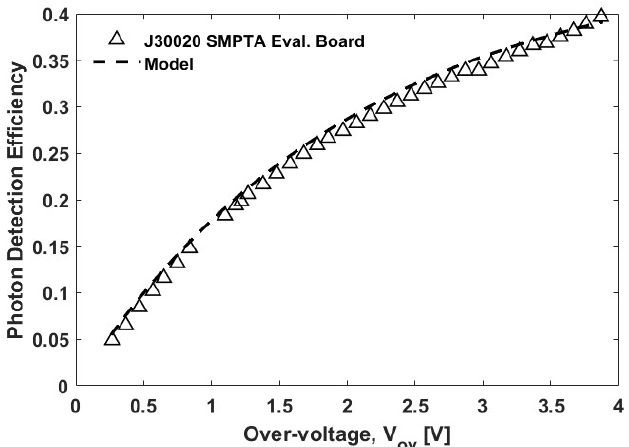
Figure 4. The photon detection efficiency of a J series 30020 SiPM on an SMPTA evaluation board measured at different over-voltages compared to Equation (1).